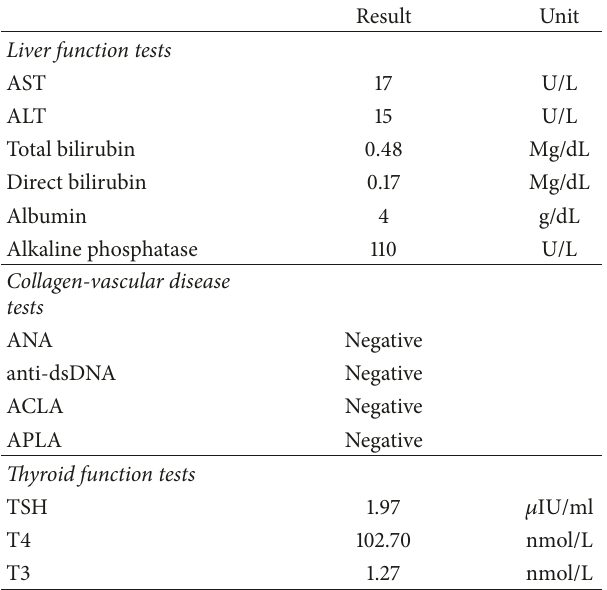
Table 1: Laboratory findings in our case